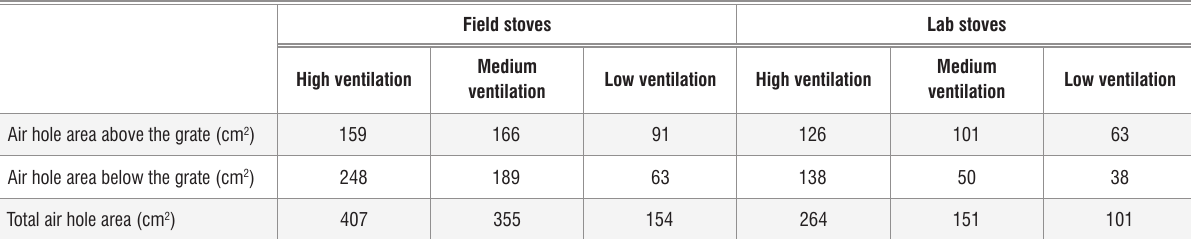
Ventilation rates of the experimental stoves